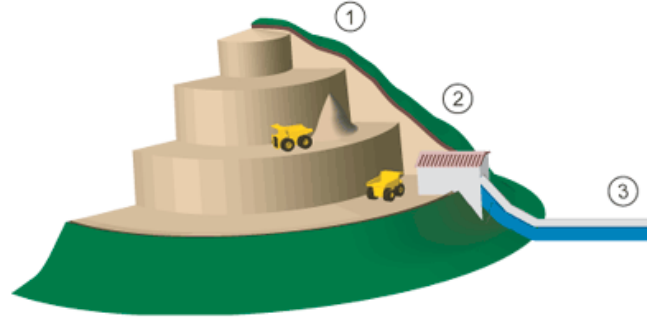
Figure 3. The first phase is mining. Source: own source.